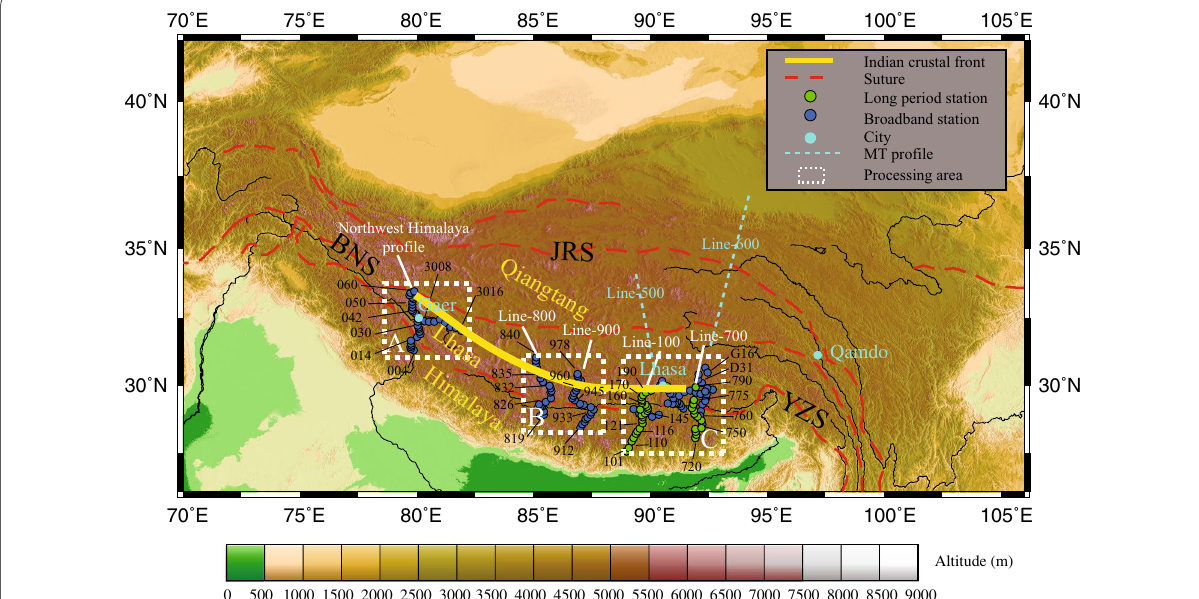
Fig. 1 Location of the MT stations (blue circles indicate the broadband data while green ones show the long period data) deployed in southern Tibet. The dashed light blue lines delineate the MT profiles line-500 and line-600. The yellow line indicates the predicted Indian crustal front. The dashed red lines show the YZS, the Bangong-Nujiang sutures (BNS), and the Jinsha River sutures (JRS). The light blue circles with light blue text delineate the cities. The white dashed frames with white capital letters (A, B, and C) mark the three processing areas (data were inverted separately in each area). The fault locations are taken from the HimaTibetmap-1.0 database (Richard Styron 2010). The figure was generated from the GTOP30 digital elevation data set using